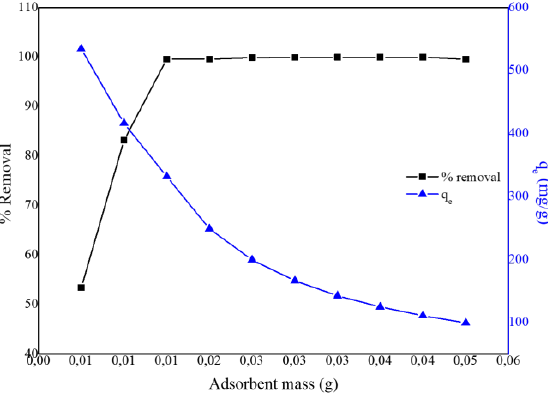
Figure 6. E ff ect of PPy- m PD / Fe 3 O 4 adsorbent dose on the removal of Cr(VI) from the solution. Figure 6. Effect of PPy- m PD/Fe 3 O 4 adsorbent dose on the removal of Cr(VI) from the solution.